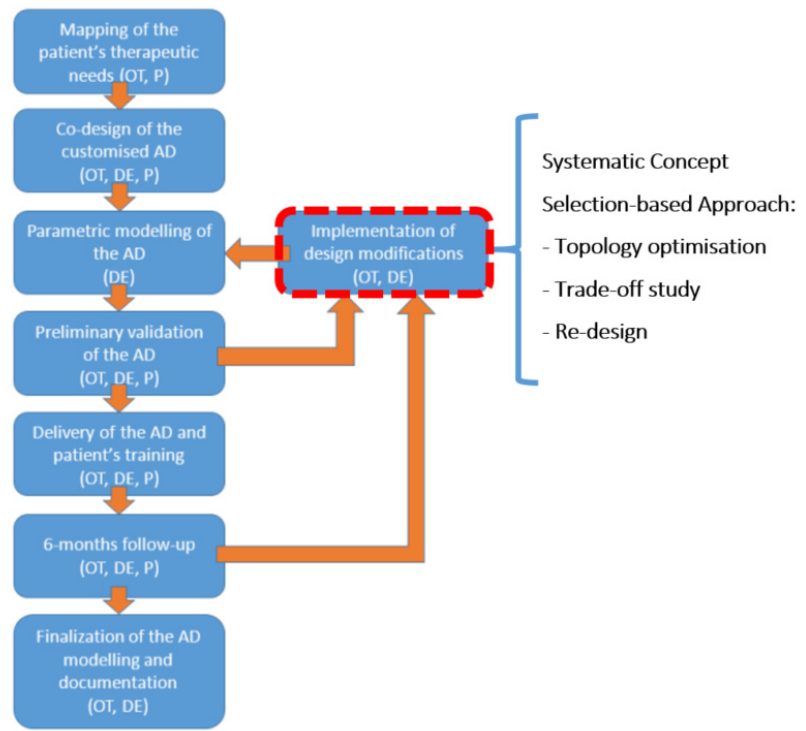
Figure 3. Workflow for the co-design of assistive devices, involving patients (P), occupational therapists (OT) and design engineers (DE). The dashed-line box highlights the iterative phases in which topology optimisation (TO), trade-off study and redesign may occur.